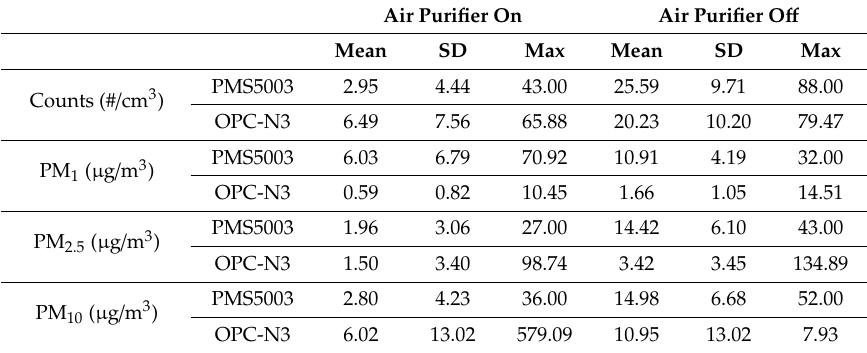
Table 5. Average PM and PN concentrations when the air purifier was